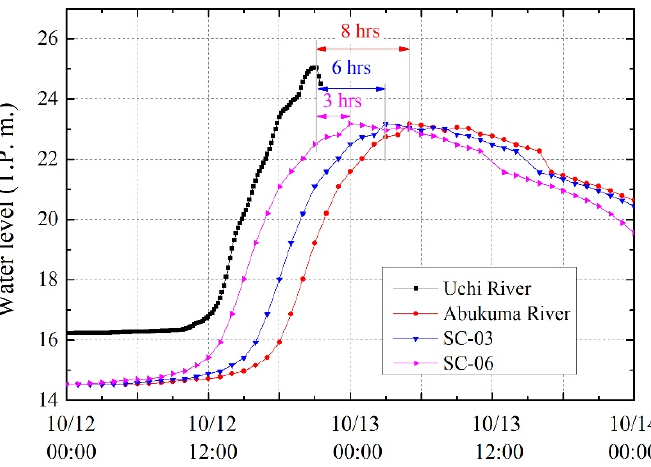
Figure 20. Phase lag difference of model scenarios.